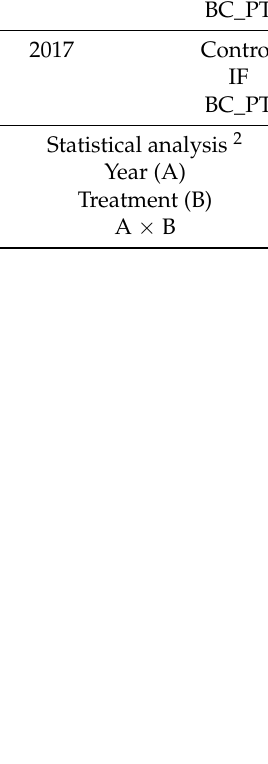
Table 3. Soil chemical characteristics after rice